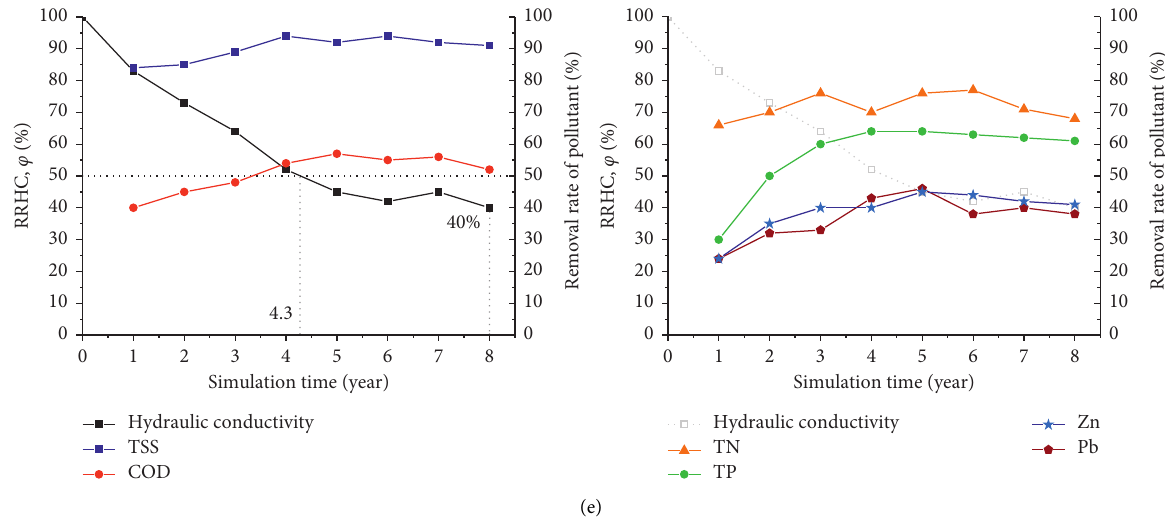
Figure 8: Long-term clogging test results of different filter media. Variations of hydraulic conductivity and pollutant concentration with simulation time: (a) Zeolite, (b) Ceramsite, (c) Slag, (d) Diatomite, and (e) Vesuvianite.